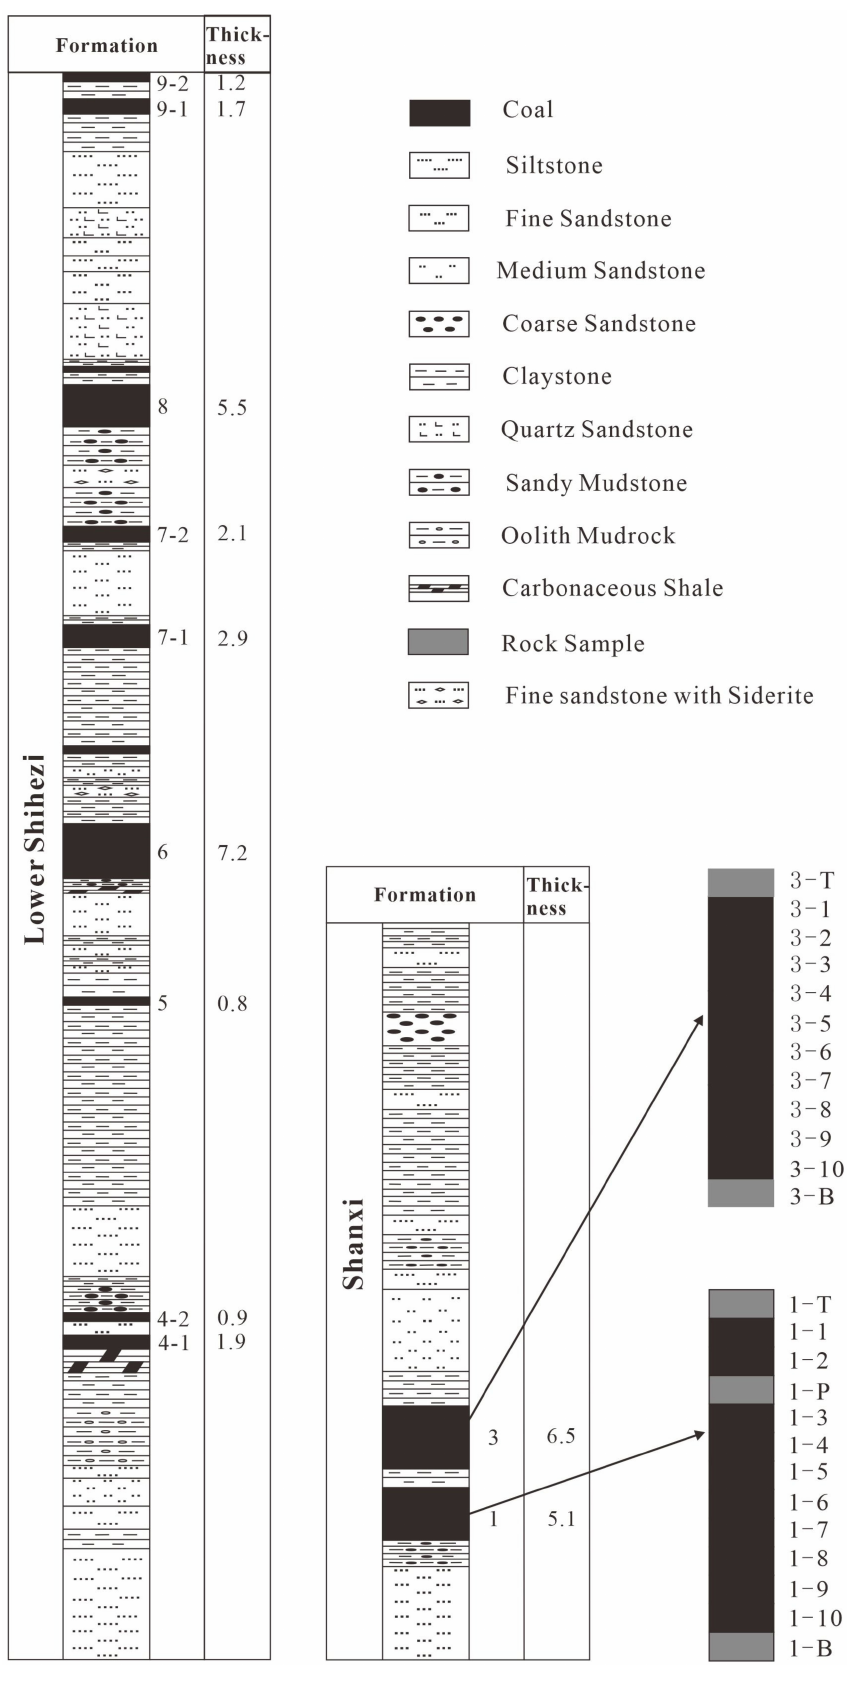
Figure 2. Generalized stratigraphic column and specific sampling points in the study